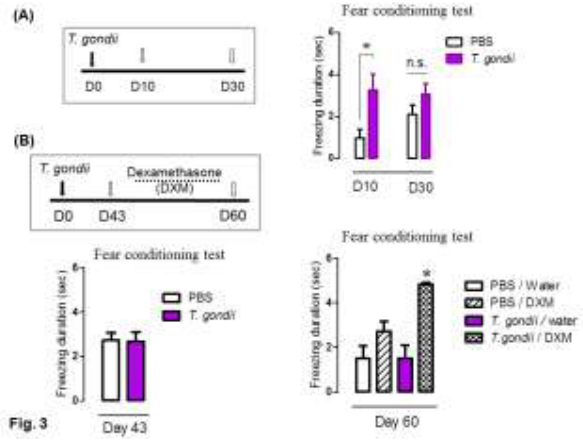
Fig. 3: Examination of freezing duration in fear conditioning test. (A) In T. gondii- infected or PBS-injected mice, freezing duration was examined at 10 and 30 dpi. (B) Freezing duration was also examined before DXM treatment in T. gondii- infected and PBS-injected groups at 42 dpi ( n = 24) and after DXM treatment in 4 groups at 60 dpi ( n = 12). Data represent mean ± SD.